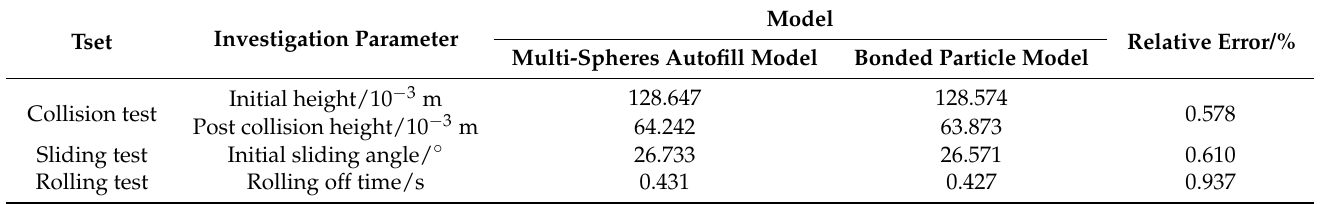
Table 12. Simulation results of two pellet